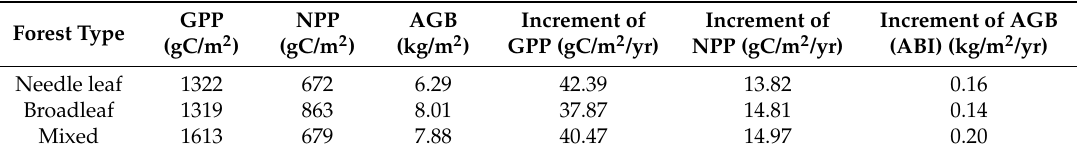
Table 5. Annual mean GPP, NPP and AGB values and their annual mean increment of different forest types from 2008 to